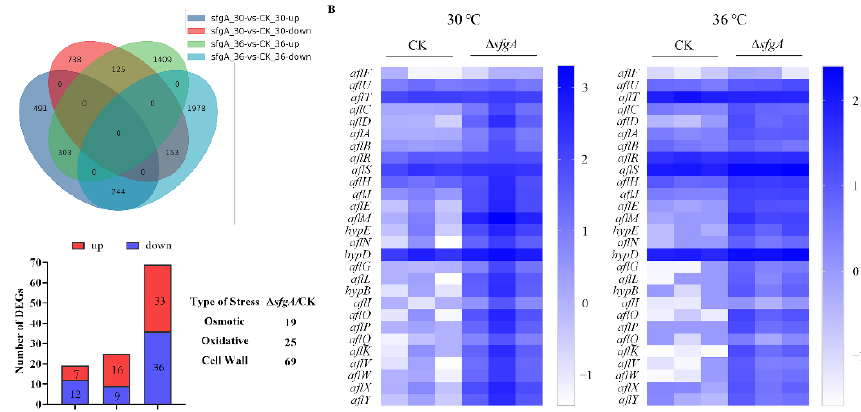
Figure 7. Transcriptome analysis of sfgA in A. flavus . ( A ) Venn diagram of common and differentially expressed gene number among different comparison groups. ( B ) Heat map showing transcript abundance of genes of the parental and Δ sfgA strains associated with aflatoxin production at 30 °C and 36 °C, respectively. The heat map is color-coded and represents the log10 value of the FPKM values of each gene in ∆ sfgA and control samples. ( C ) Impact of sfgA on the expression of stress-related genes in A. flavus at 30 °C.